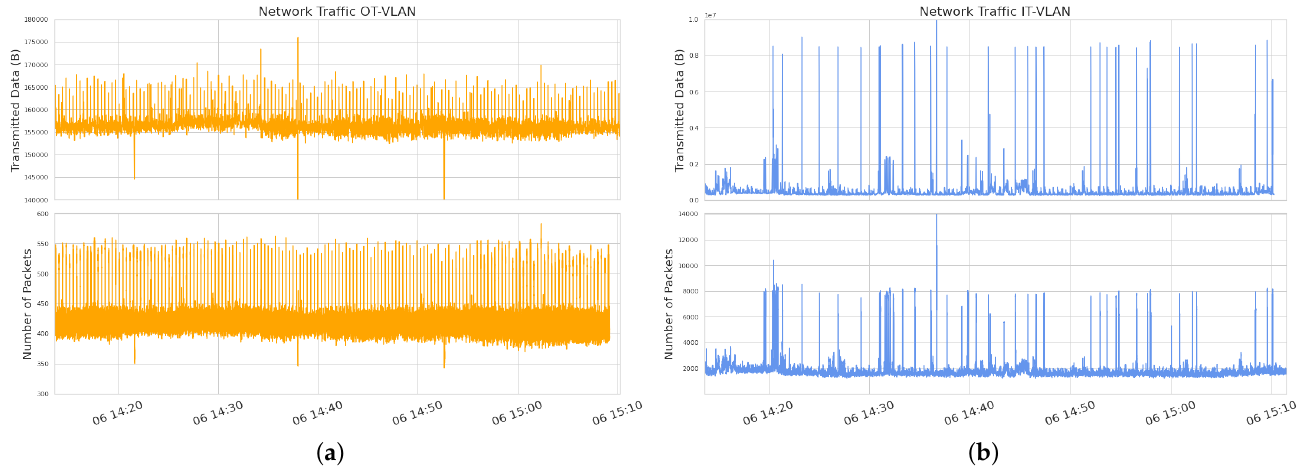
Figure 5. Traffic dynamics in the network for transmitted data and the number of transmitted packets in OT-VLAN ( a ) and in IT-VLAN ( b ).